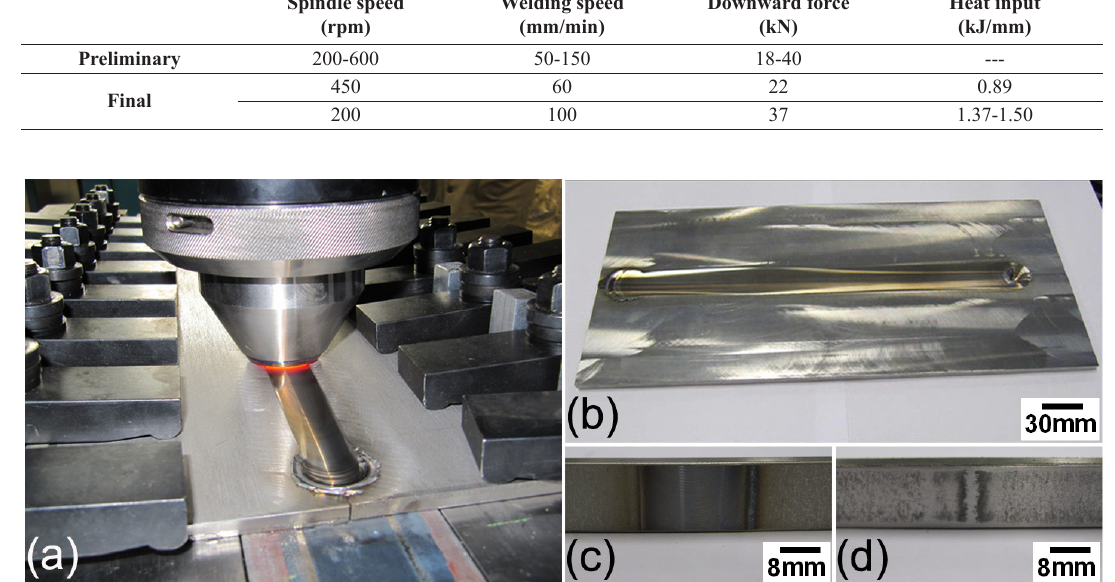
Fig. 2. (a) Friction stir welding process, (b) a welded plate showing excellent surface finish, (c) weld face, and (d) weld root.